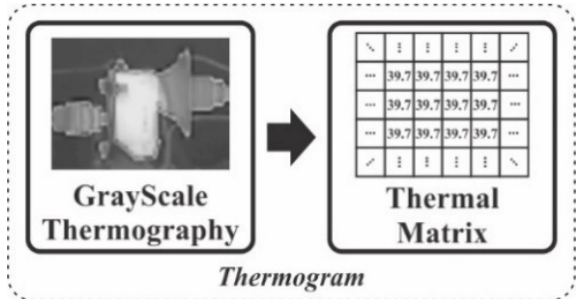
Figure 2. Thermal matrix of the infrared thermography.